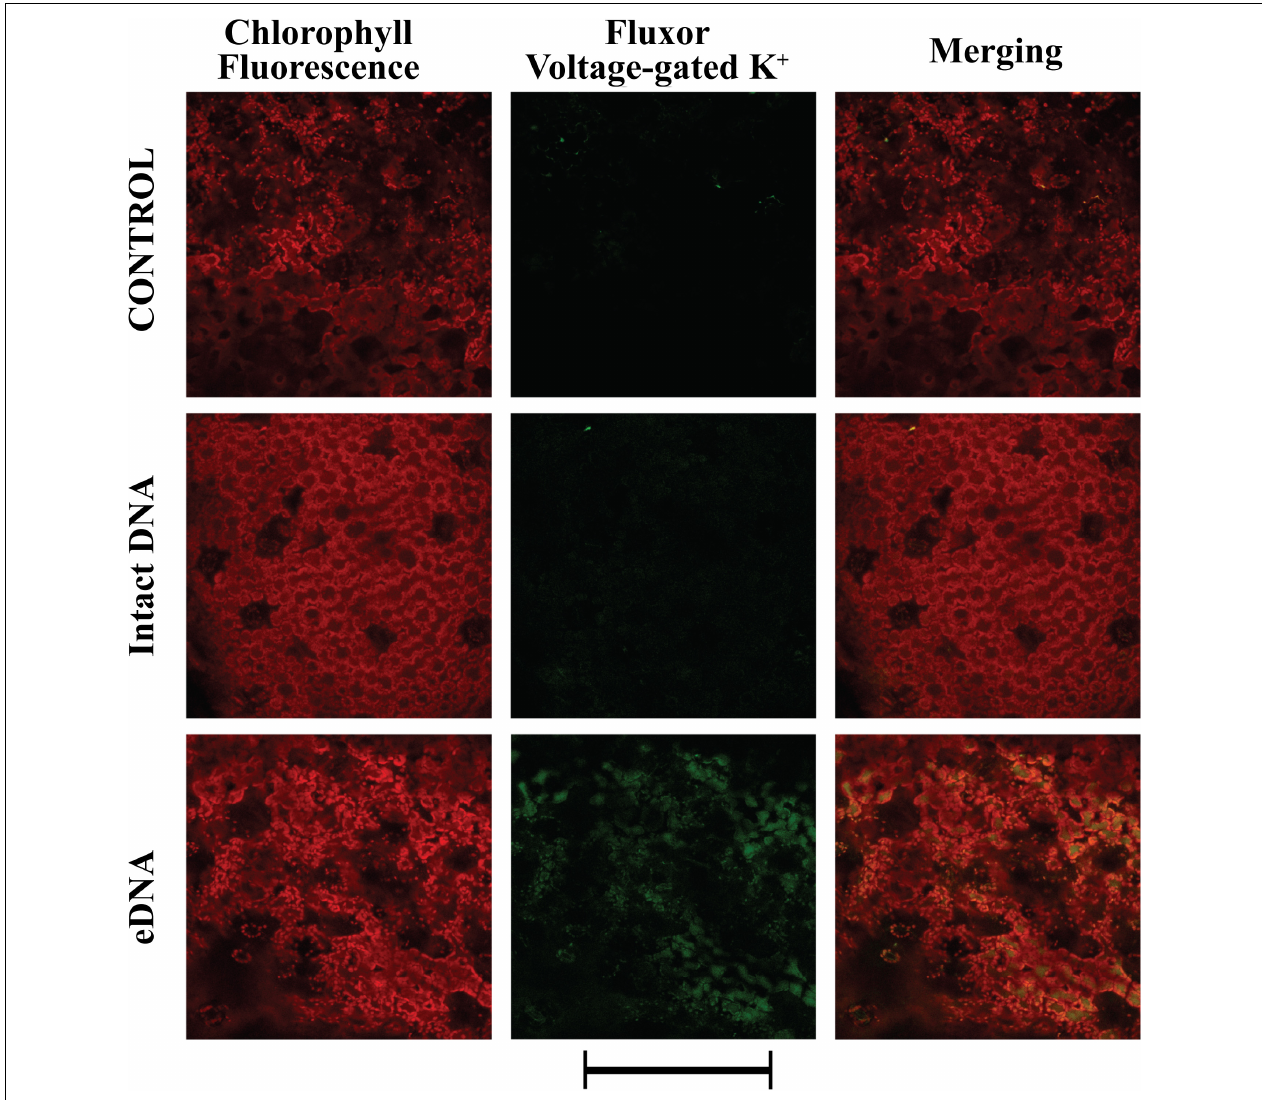
FIGURE 3 | Intracellular potassium voltage-gated variations in tomato leaves in controls (no treatment) and upon treatments with tomato intact DNA and eDNA. False-color image analysis reconstructions from confocal laser-scanning microscope observations and fluorochemical evidence of voltage-gated activity. Fifty microliters of 200 µ g ml − 1 of either eDNA or intact DNA were applied and after 50 min the K + signature was observed. Pictures represent portions of the tomato leaf blade where the green fluorescence refers to FluxOR TM associated to voltage-gated K + channel activity, whereas the chloroplasts are evidenced by a bright red color caused by chlorophyll fluorescence. Scale bar (250 µ m) is indicated at the bottom of the figure. Pictures are the results of the merging of 25 individual optical sections.